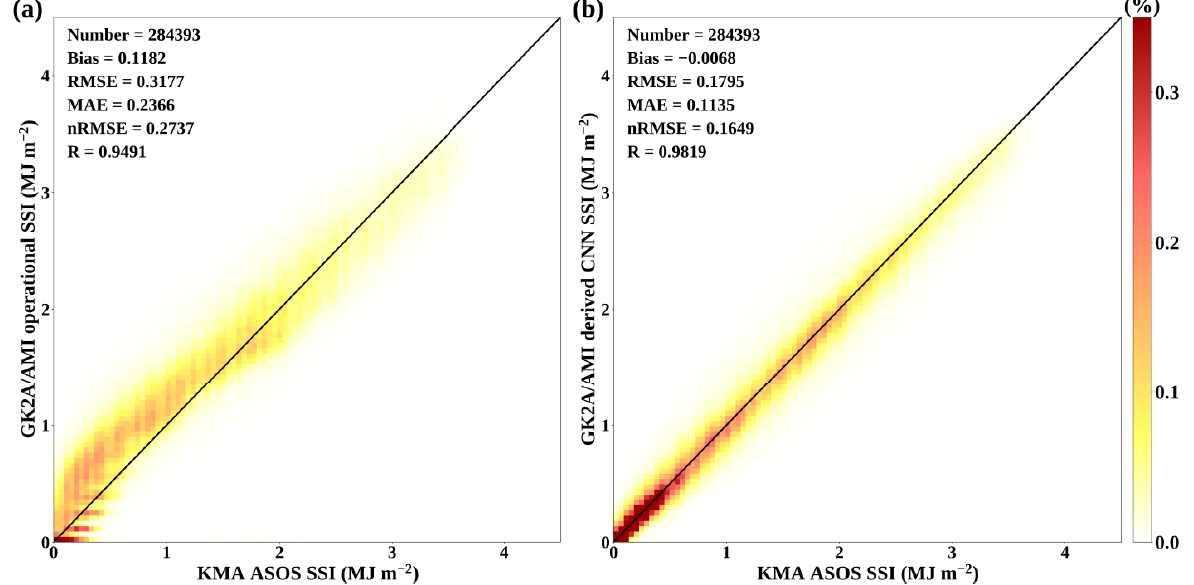
Figure 6. Validation result of the estimated SSI from GK2A/AMI and ground-based SSI from KMA ASOS stations, for the period from 1 August 2020 to 31 January 2022, using ( a ) the operational algo- rithm and ( b ) CNN, respectively; the color indicates the point density relative to the total matchups. For the period from 1 August 2020 to 31 January 2022, we verified the accuracy of the GK2A/AMI hourly SSI, as derived from the operational algorithm and the CNN model, by comparing them with in situ SSI measurements from each KMA ASOS station (Figure 7). For the operational algorithm, the RMSE values ranged from 0.210 MJ m −2 (at station 99) to 0.420 MJ m −2 (at station 185); the bias ranged from 0.008 MJ m −2 (at station 165) to 0.323 MJ m −2 (at station 185); and the Pearson’s R ranged from 0.924 (at station 115) to 0.967 (at station 185). Conversely, for the CNN model, the RMSE values ranged from 0.091 MJ m −2 (at station 137) to 0.314 MJ m −2 (at station 169); the bias ranged from − 0.082 MJ m −2 (at station 102) to 0.051 MJ m −2 (at station 146); and the Pearson’s R ranged from 0.946 (at station 169) to 0.991 (at station 137). Overall, the CNN model showed lower RMSEs and higher R values than the operational algorithm at all KMA ASOS stations, which indicates that the CNN model estimated the SSI more accurately. In particular, at stations 115, 169, and 172 (hereafter referred to as group 1), regardless of the model, high RMSEs and low values of Pearson’s R were observed compared to other stations. In contrast, at stations 112, 168, 184, and 185 (hereafter referred to as group 2), the CNN showed a low RMSE, and the operational algorithm showed a high RMSE, which could have been caused by a high positive bias.